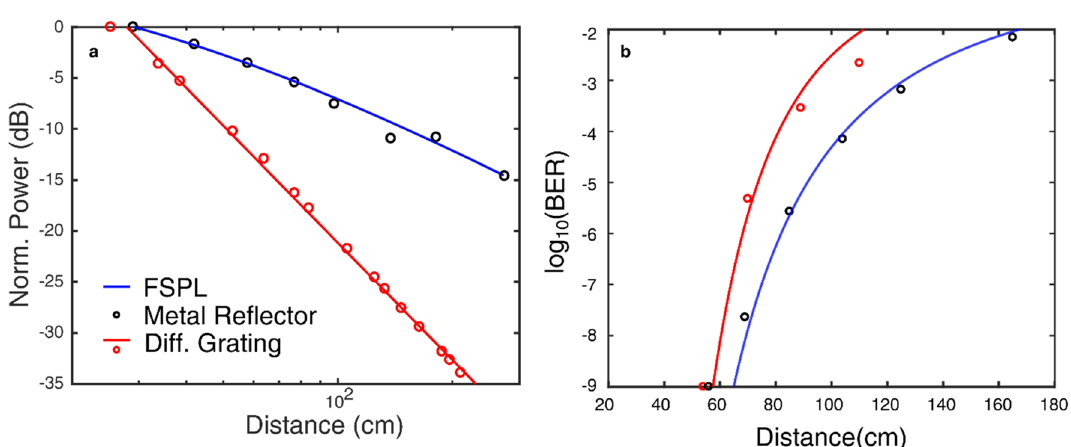
Figure 2. ( a ) The normalized power detected at the receiver positioned at an angle of 35.5° for a metal reflector (black circle), and angles corresponding to the primary lobes of the diffracted signal when the grating spacing is (cid:31) = 2.58mm (red circle). As the distance increases the attenuation of the signal is greater when using a diffraction grating than compared to a metallic reflector. The slope of the linear fit is 34.7 (dB/decade) for the signal diffracted by the grating (red line). The FSPL is also plot against the metal reflector data (blue line). ( b ) The measured BER for the uncompressed grating (red dots) is greater compared to a metal reflector (black dots) as the receiver distance is increased for a given transmitter power. The calculated BER for the metal reflector (blue line) only experiences FSPL and increases at a slower rate in comparision to the higher BER predicted for the signal from the diffraction grating (red